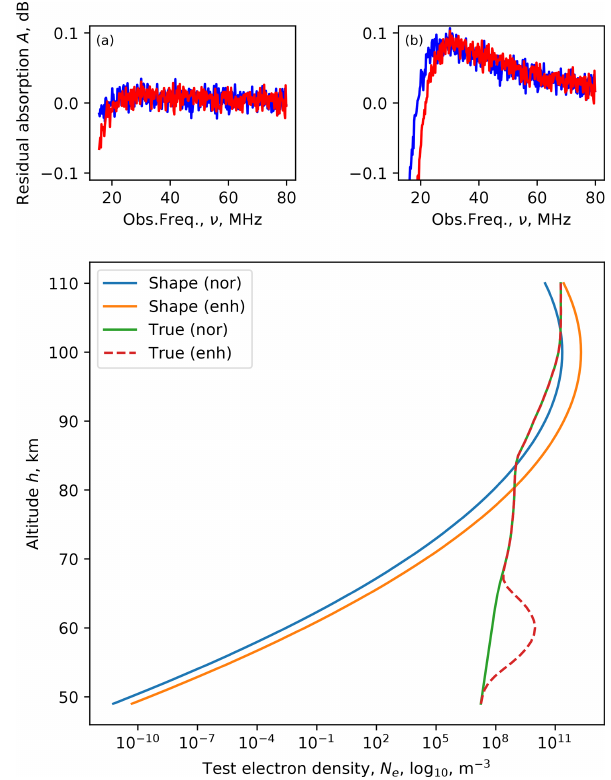
Figure 12. Fitting a 100km peak Gaussian electron density pro- file to simulated normal and enhanced ionospheric profile data. The residuals are shown in the two top panels as a function of the ob- serving frequency: (a) normal and (b) enhanced, with the o mode shown in blue and the x mode in